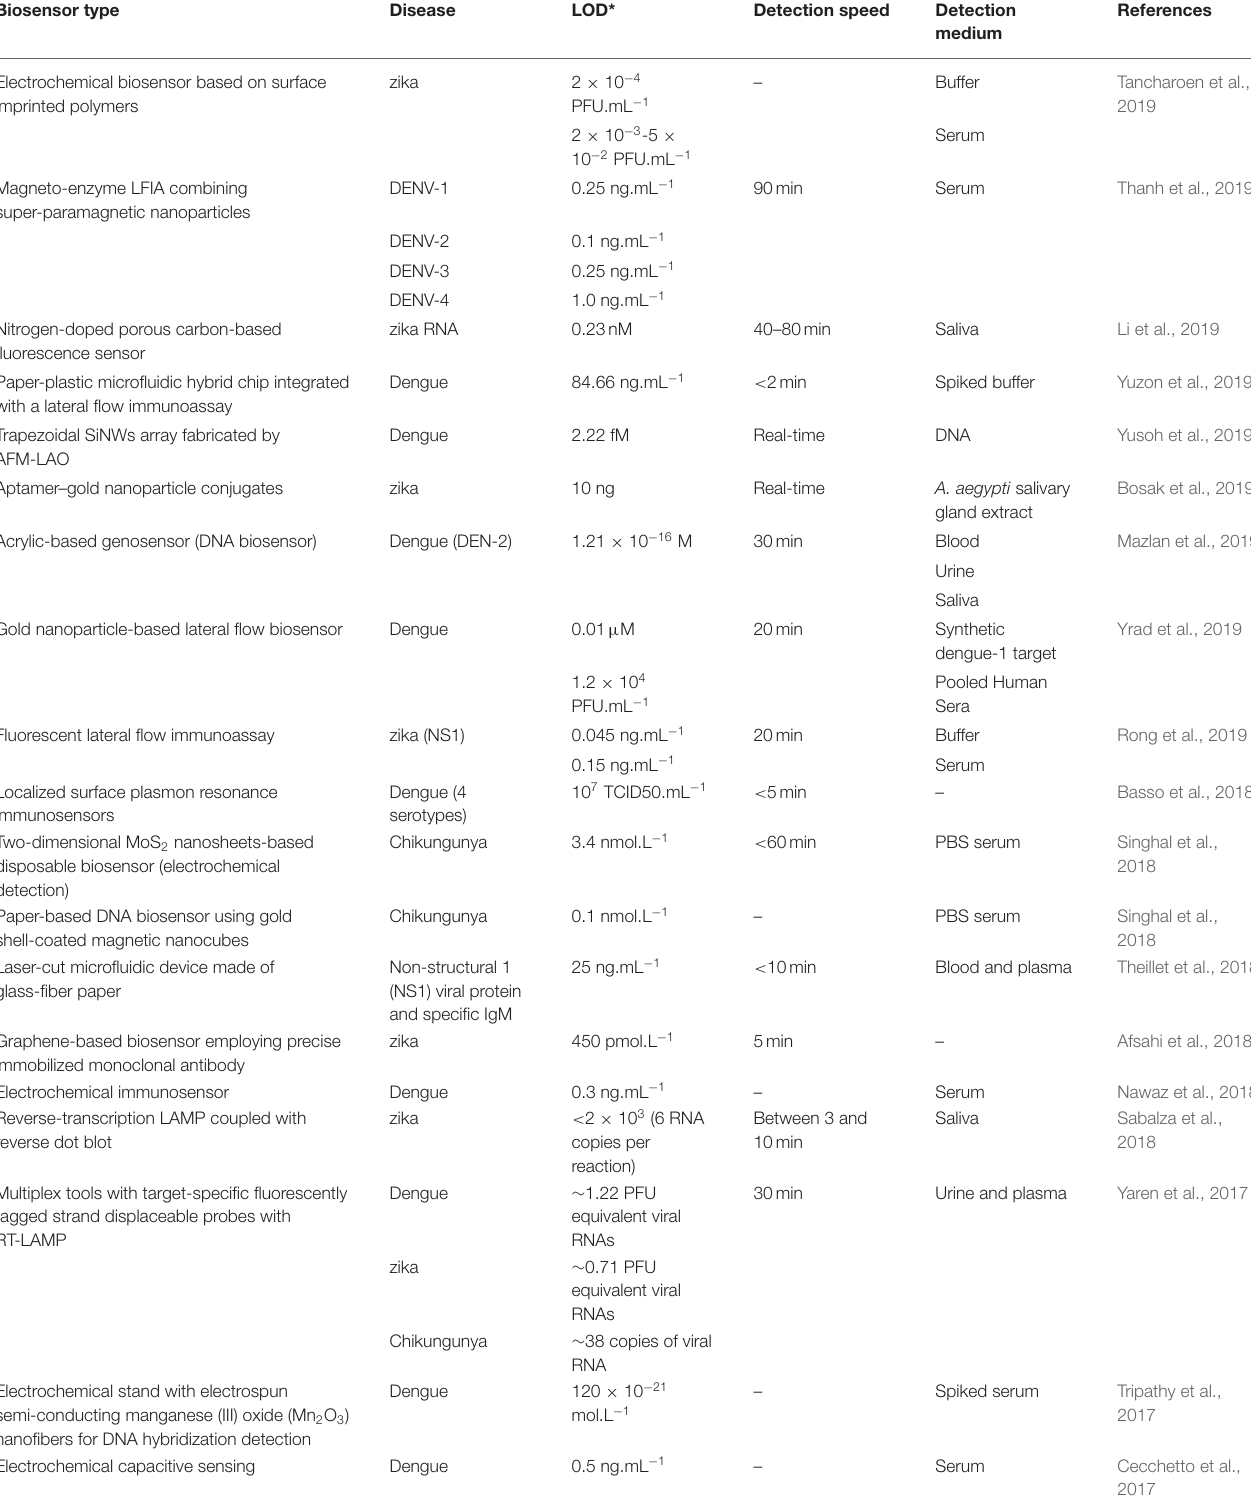
TABLE 1 | Main biosensors developed for the detection of arboviruses, together with their operational principles and